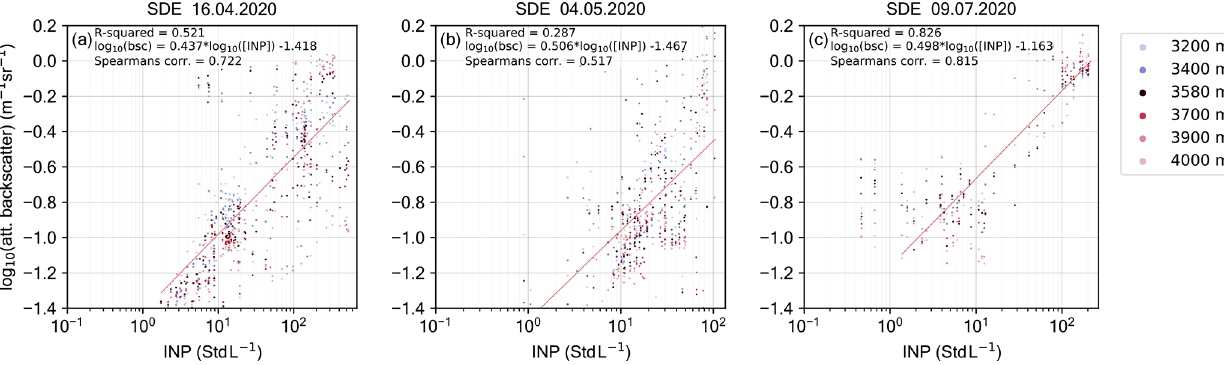
Figure 9. Scatter plots of simultaneous INP concentrations and attenuated backscatter signal at KSE for an SDE starting 16 April ( a ), 4 May ( b ), and 9 July ( c ). Shown are the median ceilometer measurements during the period of each INP measurement, with the correspond- ing correlation parameters and the linear fit (red line).